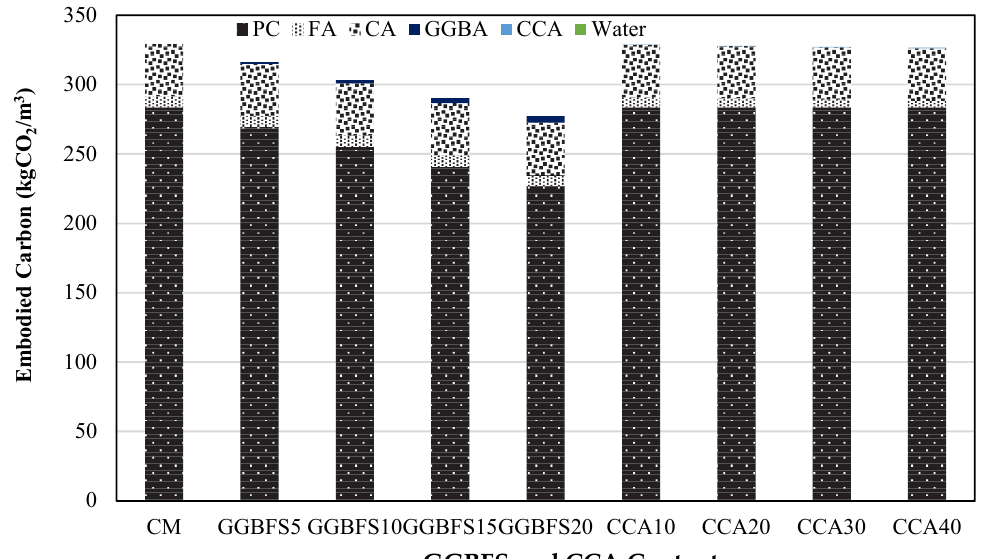
Figure 16. Embodied carbon of concrete containing GGBFS and CCA.